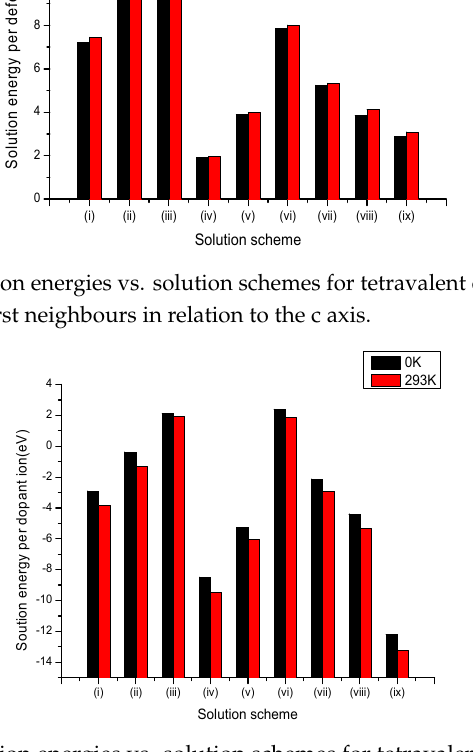
Figure 5. Bar chart of solution energies vs. solution schemes for tetravalent dopant (Mo 4 + ) at the Li and Nb sites, considering the first neighbours in relation to the c axis.